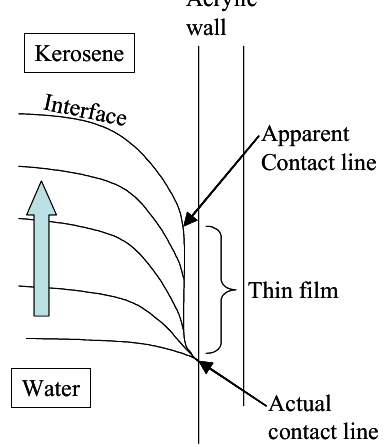
Fig. 1 Test geometry.